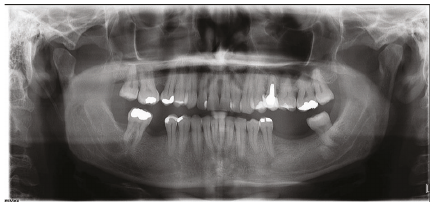
Figure 4: Patient ’ s orthopantomogram (OPG) showing bone healing after a 2-year follow-up.